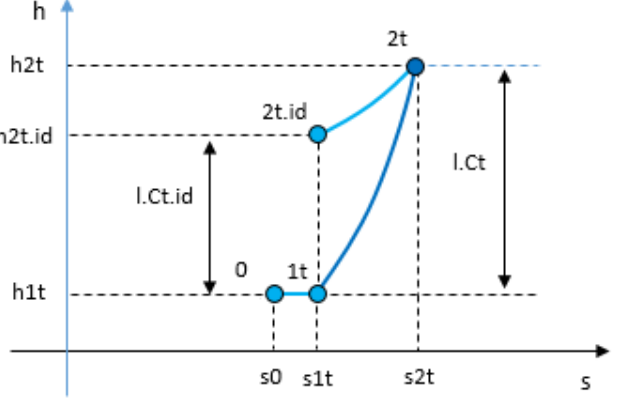
Figure 5. Compressor enthalpy–entropy diagram.